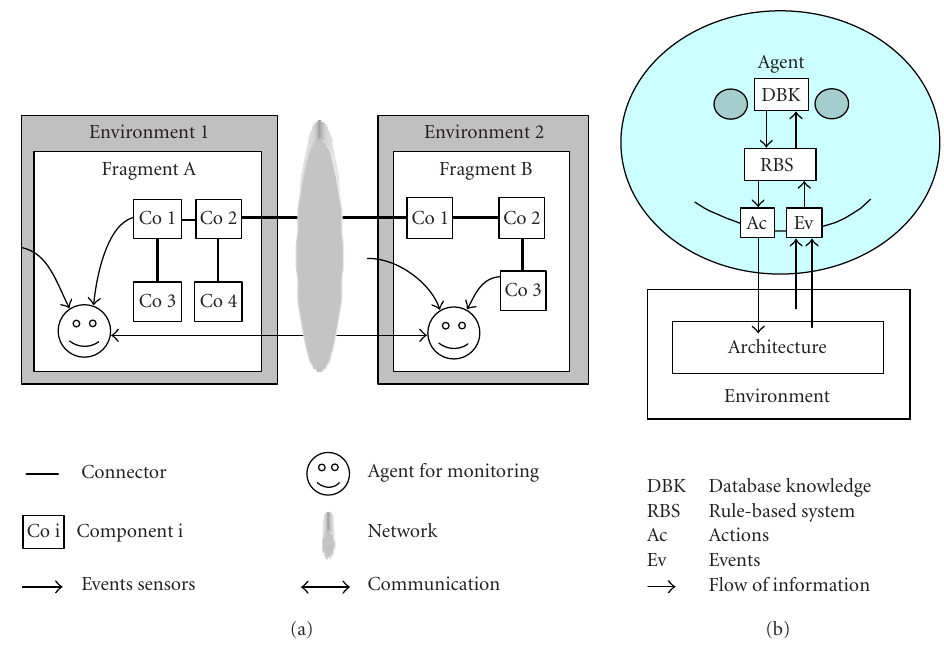
Figure 3: (a) Agent-based architecture. (b) Schematic overview of the